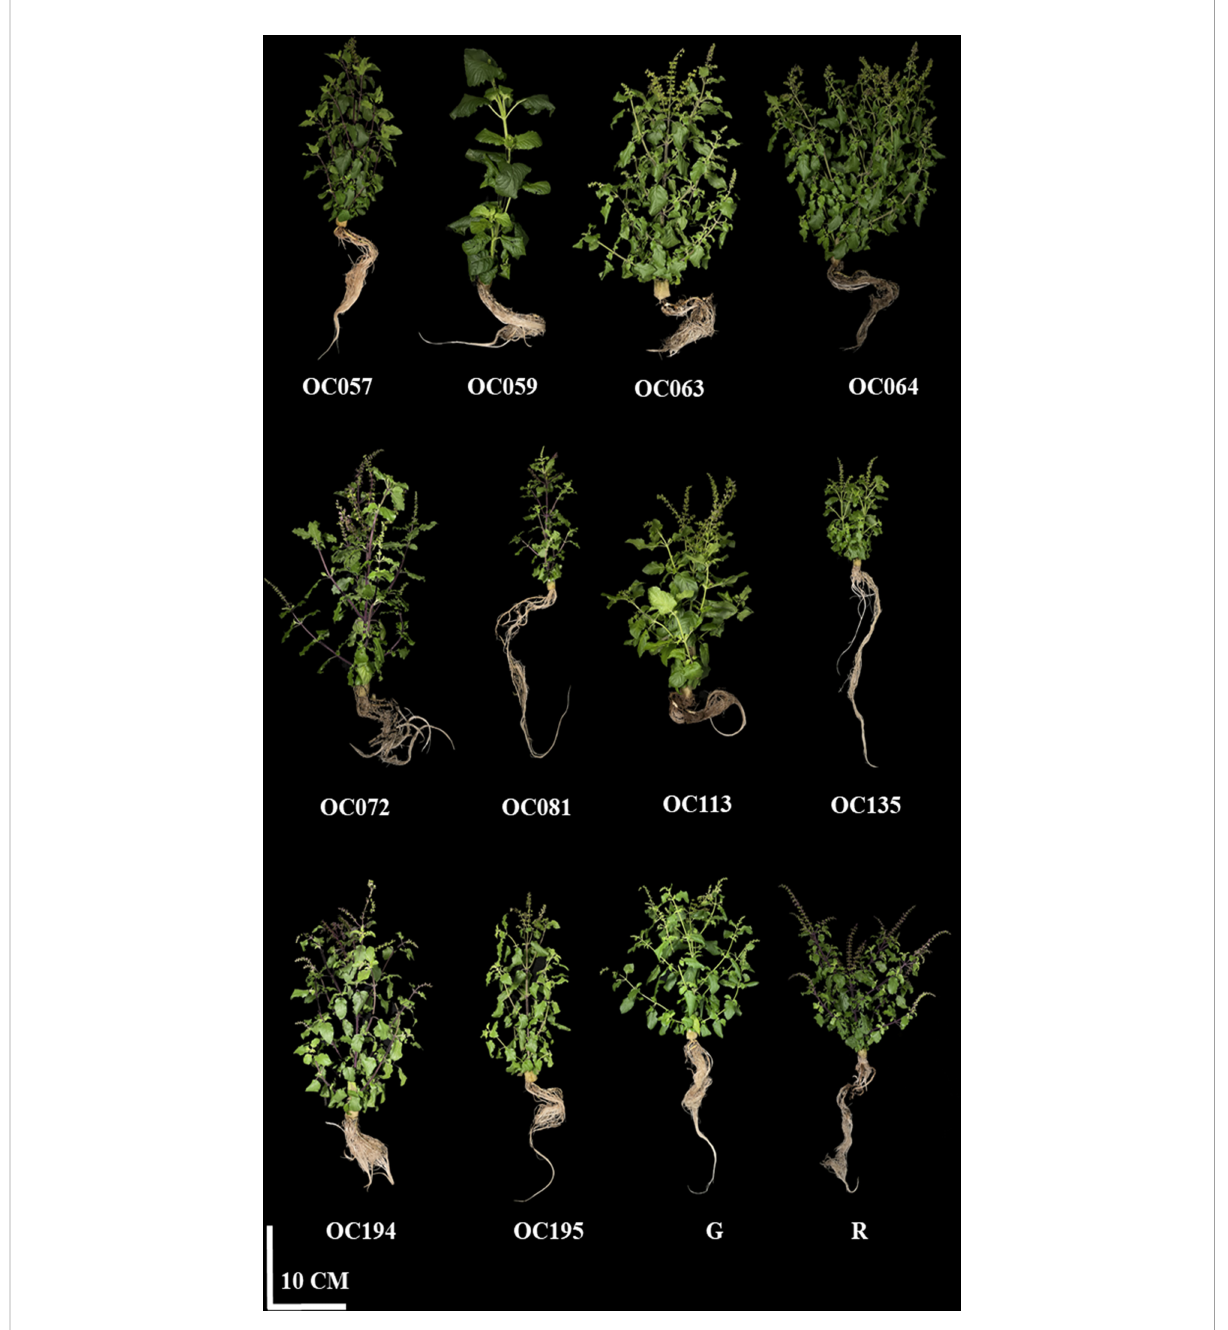
FIGURE 2 The morphology of Thai holy basil cultivars/accessions at the fl owering stage. R and G represent the red and green commercial cultivars,